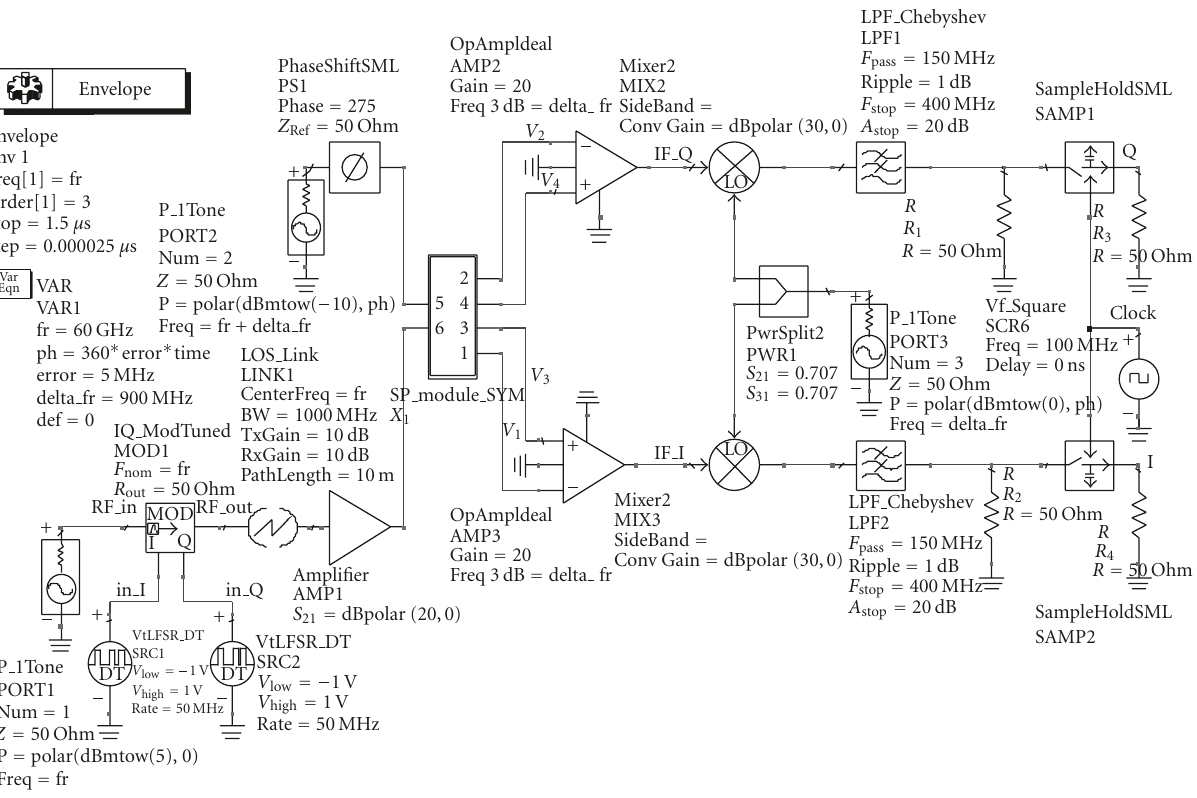
Figure 9: ADS simulation block diagram of the multiport heterodyne